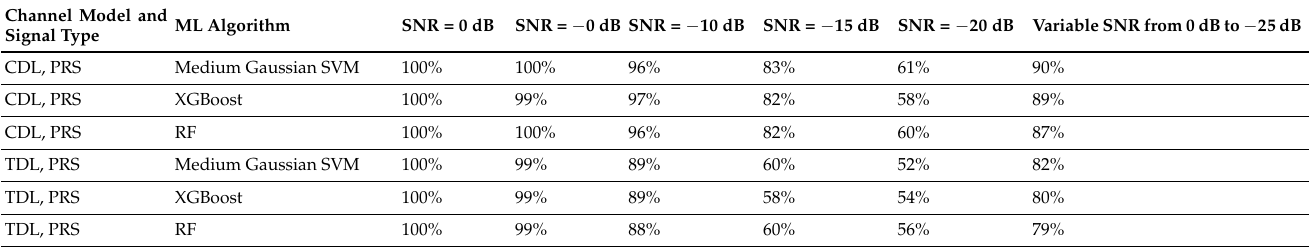
Table 6. Example of the SNR impact on the LOS detection accuracy ([%]) with simulated data.